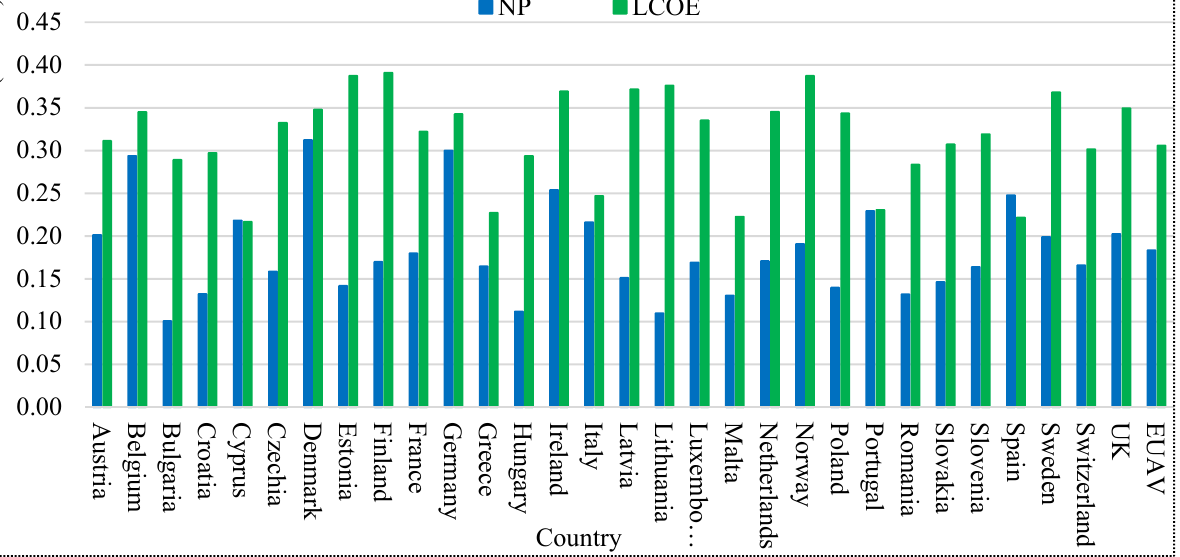
Figure 8. NP and LCOE of a non-optimal solution.